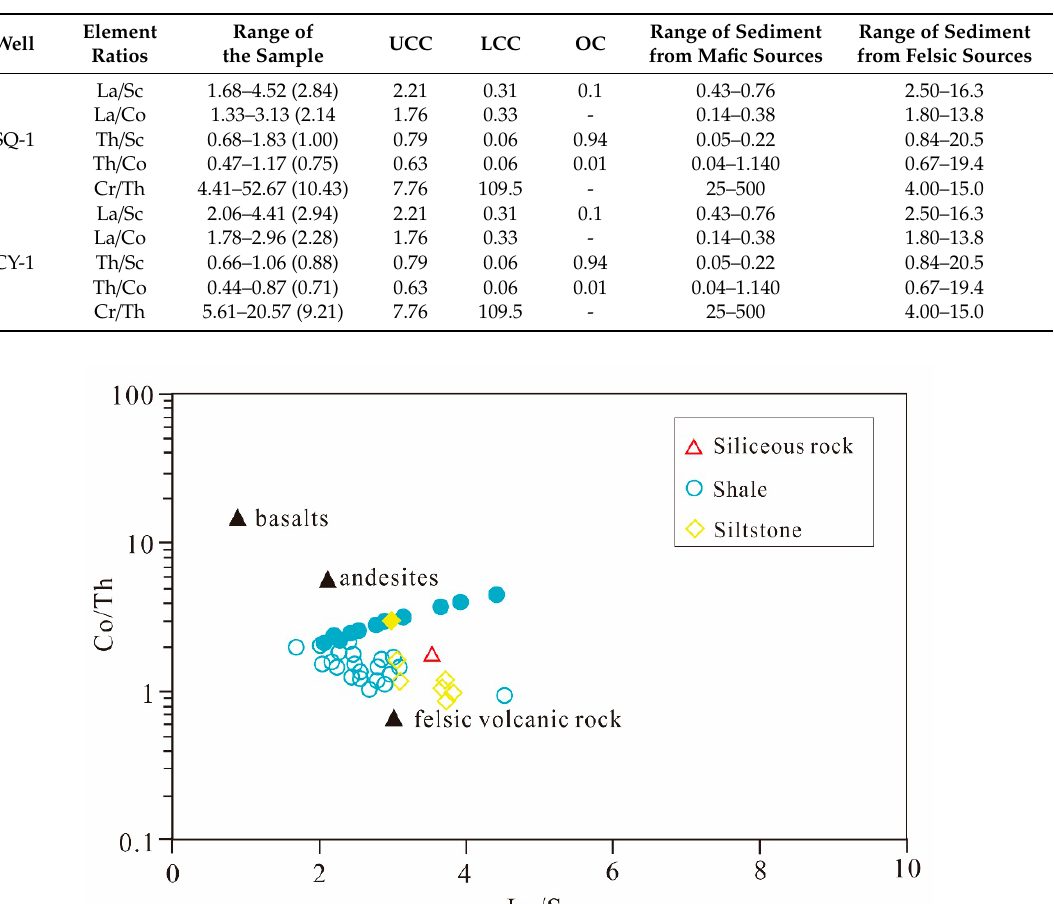
Table 1. Range of several elemental ratios of the samples from the SQ-1and CQ-1 compared with the counterparts in sediments originated from the upper continental crust (UCC), lower continental crust (LCC), oceanic crust (OC), mafic rocks, and felsic rocks.